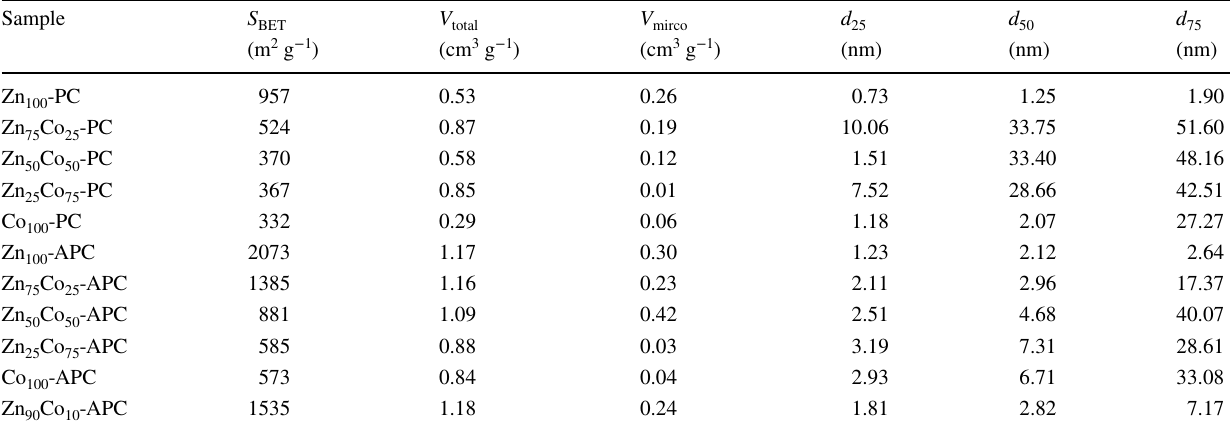
Table 1 Summary of the porosity parameters for as‑prepared samples